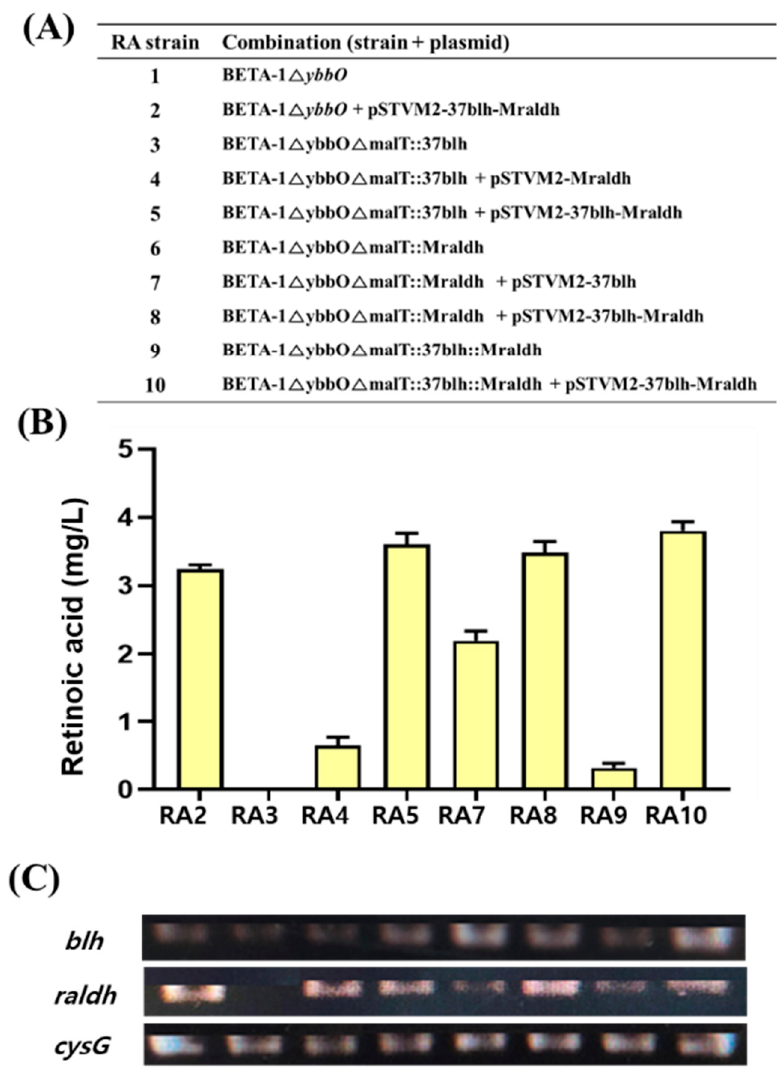
Figure 4. Retinoic acid production and mRNA expression level of the UTR37- blh SR and UTRM- raldh genes in retinoic acid – producing strains. ( A ) List of strains constructed through genome editing and transforming plasmids into the genome-edited strains. ( B ) Retinoic acid production from eight metabolically engineered strains grown in flask cultures. ( C ) mRNA expression level of UTR37- blh SR and UTRM- raldh genes in ten strains grown in flask cultures. The cysG gene, encoding siroheme synthase, was used as a reference gene.